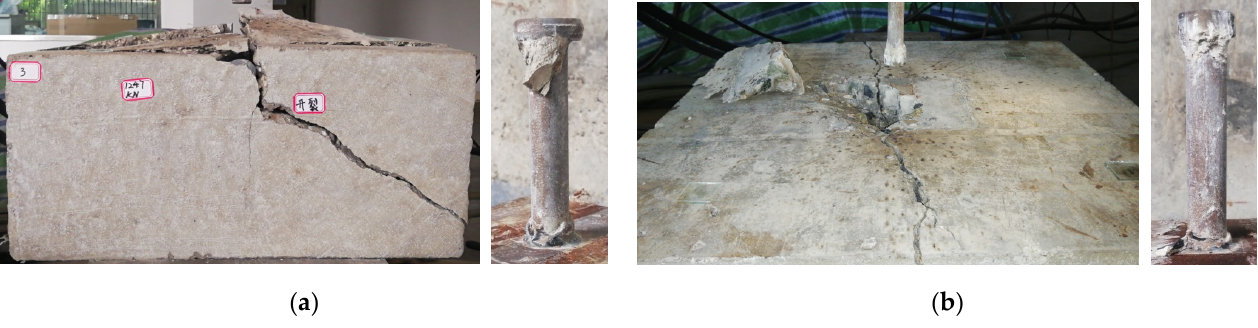
Figure 5. Failure modes of specimens after the studs were pulled out: ( a ) NC19-2; ( b ) NC19-38.